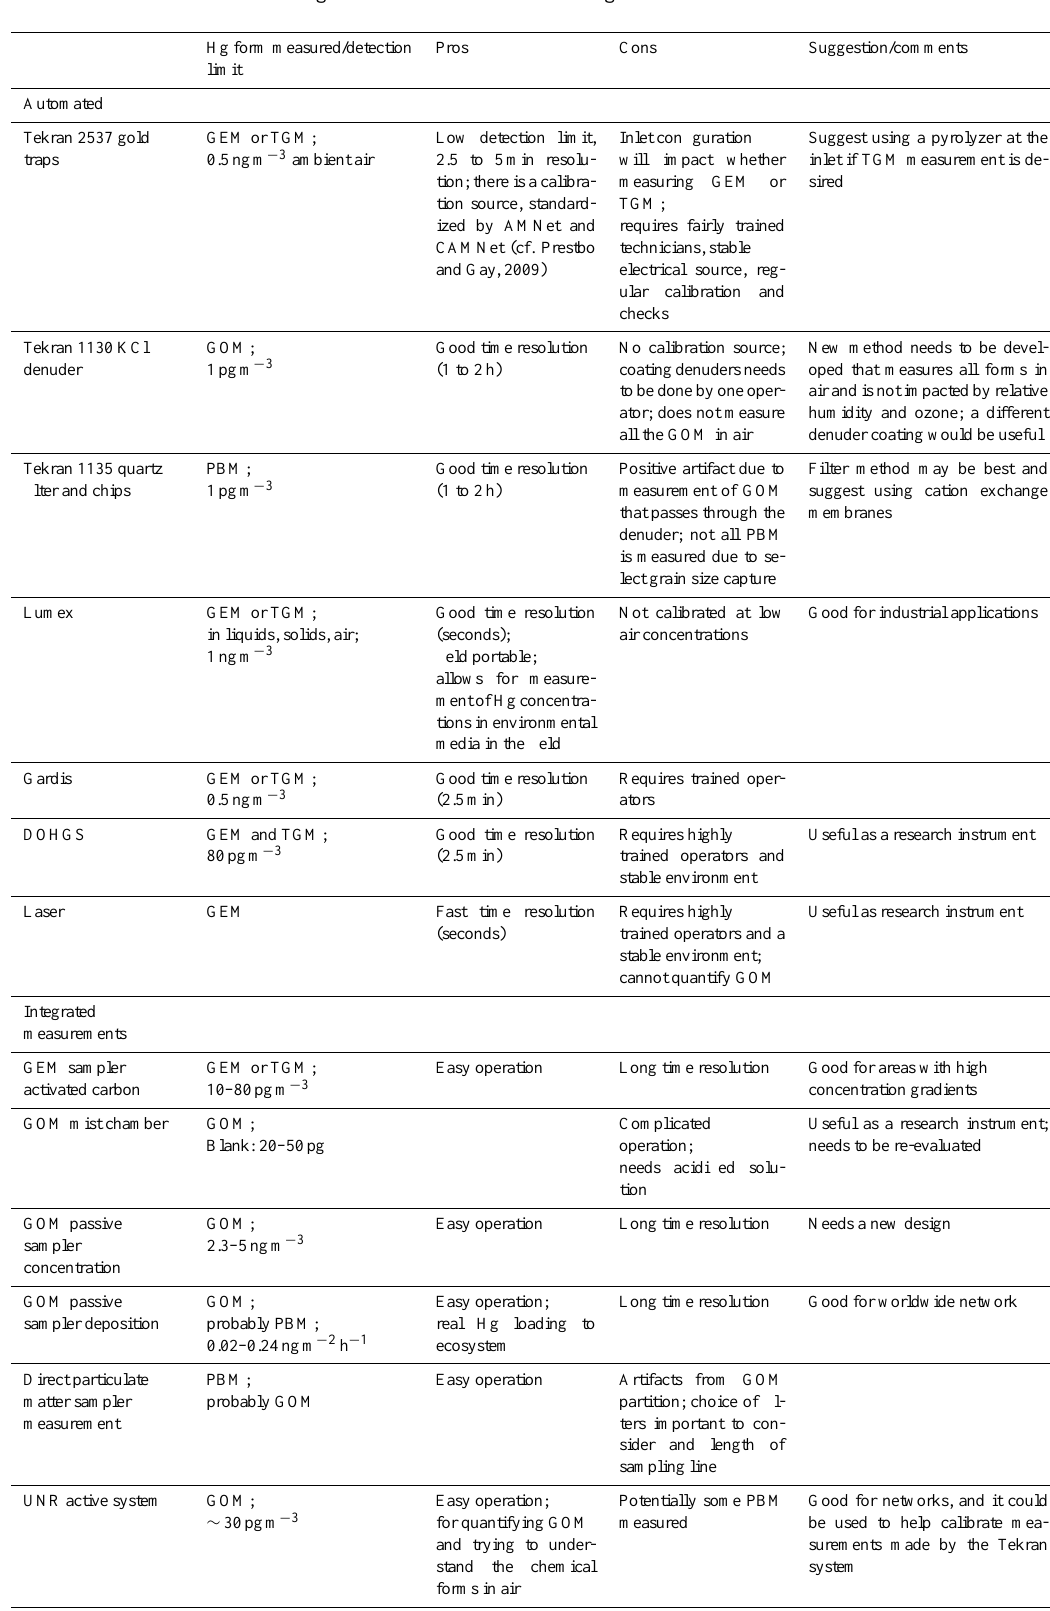
Table 1. Pros and cons of automated and integrative methods used to make Hg measurements. Hg form measured/detection Pros Cons limit